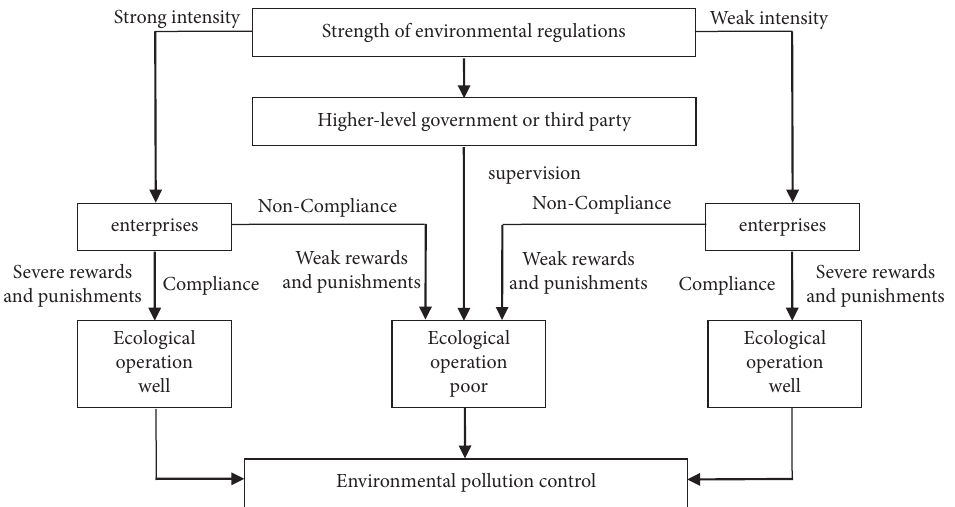
Figure 1: The game mechanism between the government environmental regulation intensities and the pollutant emissions from pa- permaking